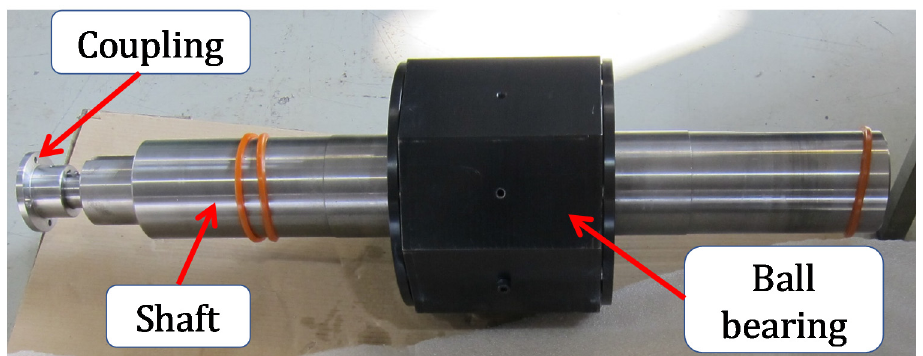
Figure 6. Photo of shaft and rolling bearing. Actuators 2020 , 9 , x FOR PEER REVIEW